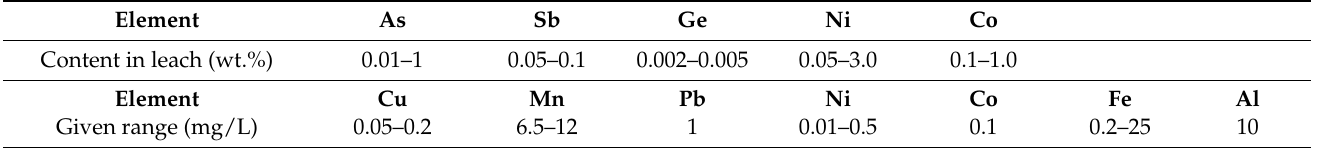
Table 1. Limit contents of elements in solutions for zinc separation by electrolysis [24,33]. Element As Sb Ge Ni Co Content in leach (wt.%) Element Given range